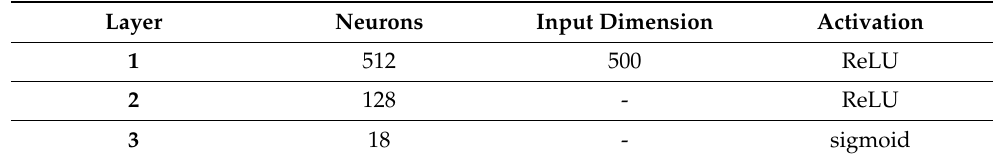
Table 8. MLP layer characteristics.